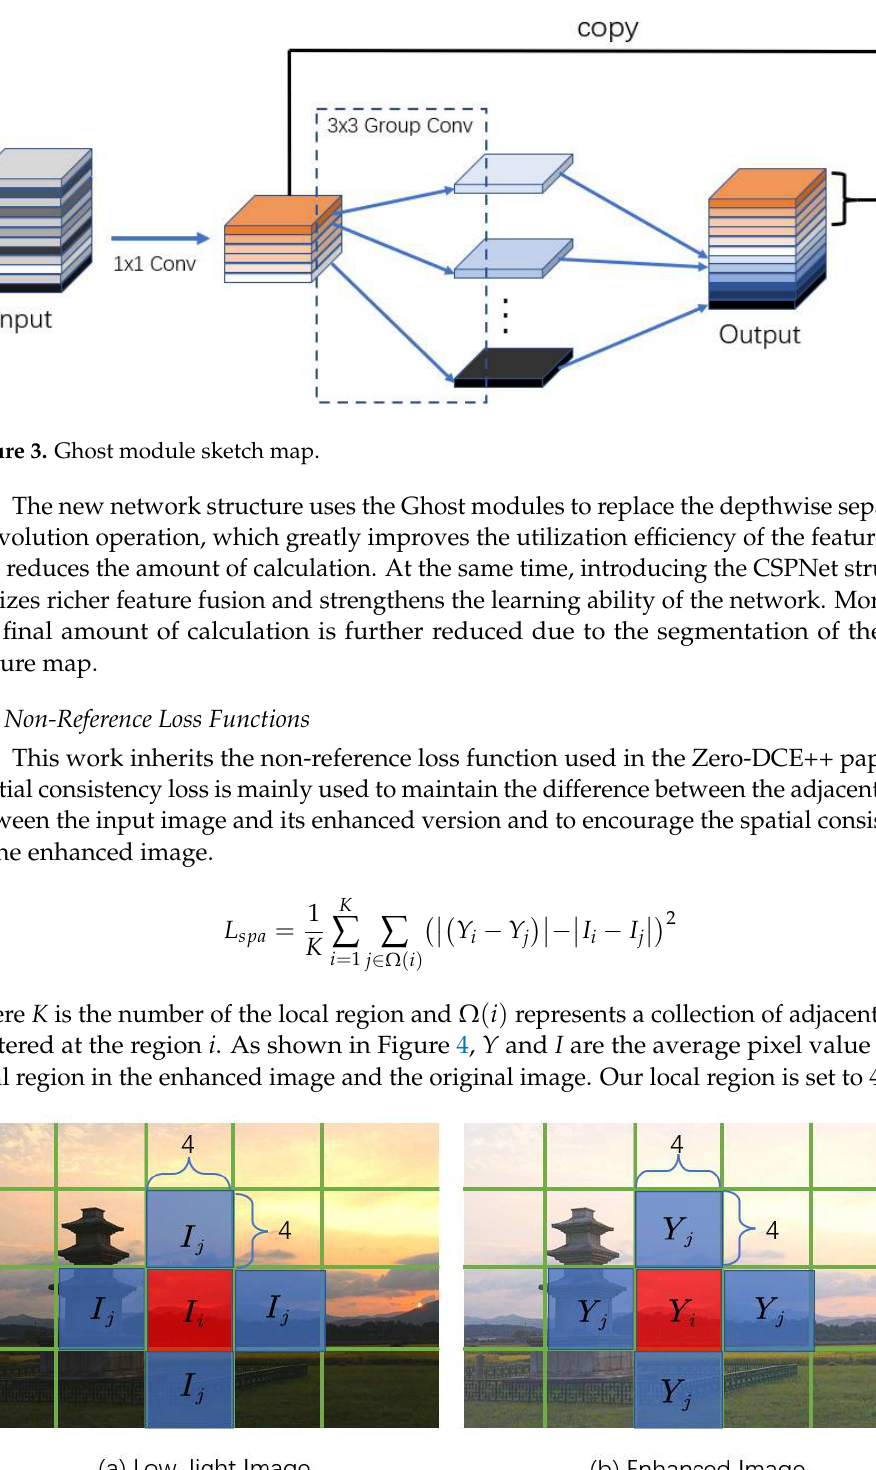
Figure 2. Zero-DCE Tiny structure diagram.